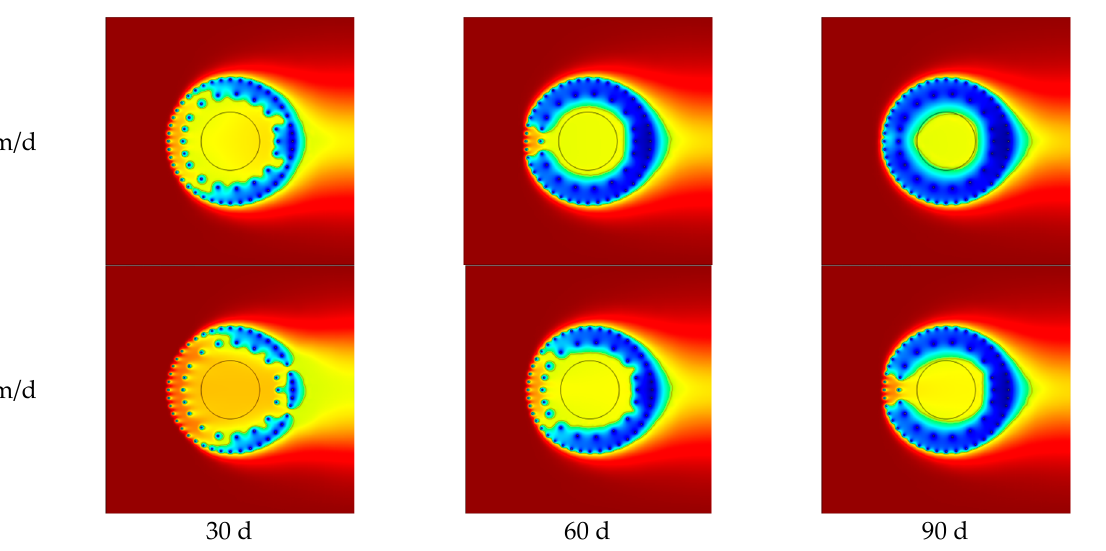
Figure 16. Development law of the freezing temperature field of the double-circle holes after optimization.